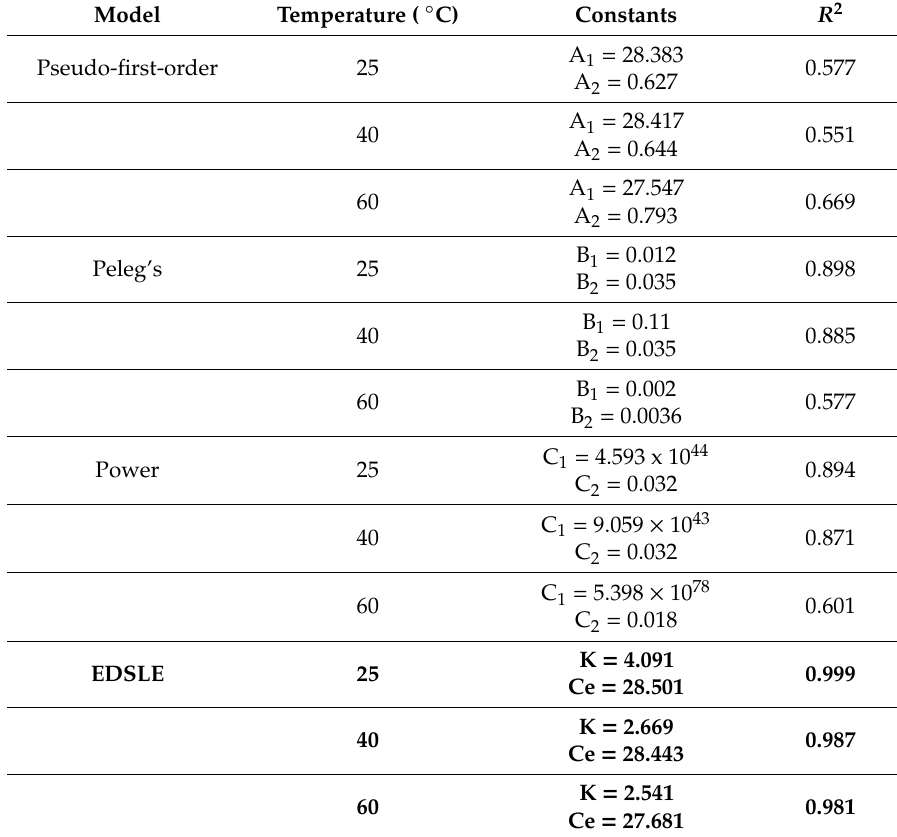
Table 3. Kinetic models for thymol extraction at di ff erent